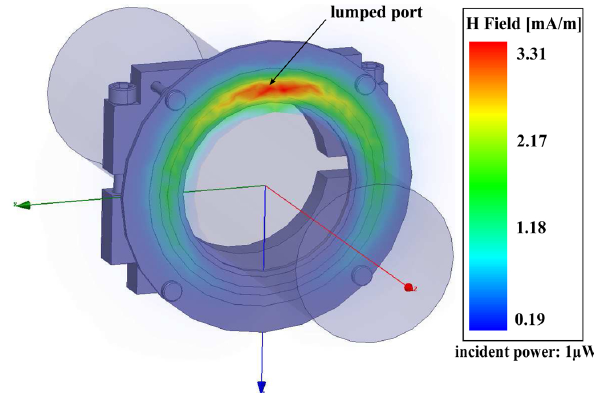
Figure 8. Simulated magnetic field at 3mm from the receiving ca- pacitive coupler element surface.